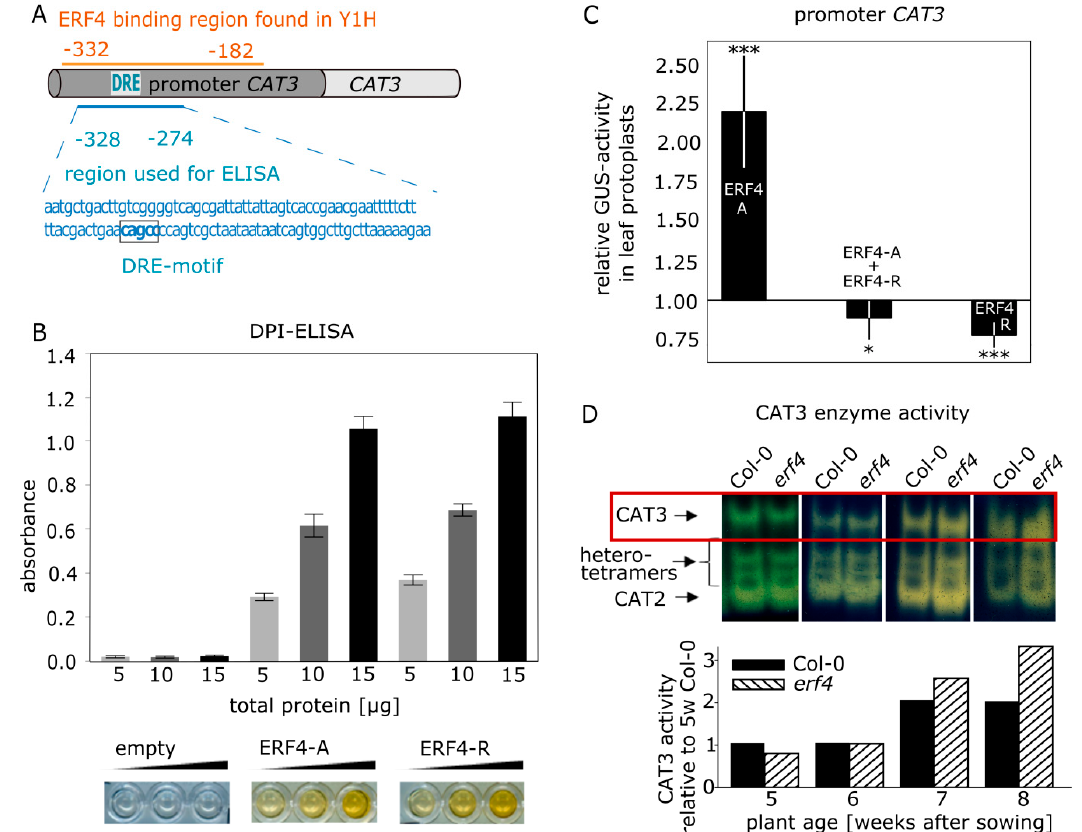
Figure 5. ERF4 binds to the CATALASE3 promoter and can act as activator and repressor. ( A ) Schematic representation of the CAT3 promoter fragments used for Y1H screen and for DPI-ELISA. ( B ) DPI-ELISA using bacterial crude extracts of E. coli BL21 Rosetta cells expressing 6xHis-ERF4-A, 6xHis-ERF4-R or the empty vector and a 55-bp biotinylated DNA fragment of the CAT3 promoter, which contains the DRE motif CAGCC. Representative wells of the micro titer plate are shown below the graph. Yellow color indicates interaction. Error bars indicate ± SE, n = 4–5. ( C ) Transient expression assays were performed using the 1.8 kbp fragment of the CAT3 promoter upstream of the start codon in Arabidopsis Col-0 and erf4 leaf protoplasts. Values represent fold-change of GUS-activity relative to the empty vector after normalization to luciferase activity to compensate for differences in transformation efficiency. Data are means of seven experiments ( n = 7). Statistical differences were analyzed by one sample t-test (* p ≤ 0.05, ** p ≤ 0.005, *** p ≤ 0.0005). ( D ) Enzyme activity of catalase isoforms of Col-0 and erf4 mutant plants is visualized on a zymogram. Protein crude extract (10 µ g) of leaf No. 6 of 5- to 8-week-old plants were separated on 7.5% native gels and stained for catalase activity. Proteins were extracted of a pool of at least 10 leaves. Intensities of the CAT3 bands were quantified using ImageJ.